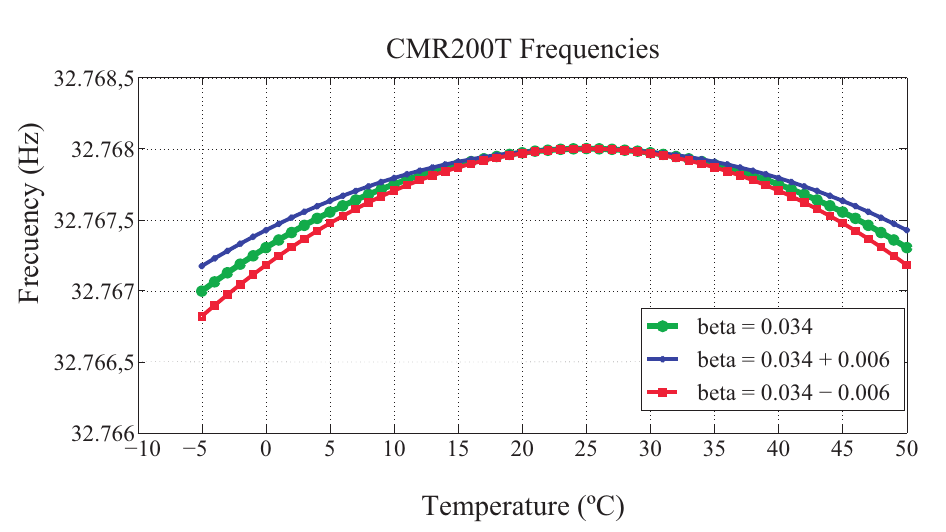
Figure 2. Clock skew in Citizen